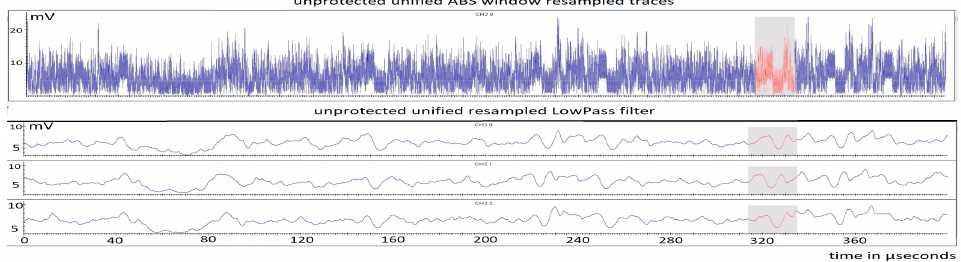
Figure 2: Applying low pass filter to find good alignment